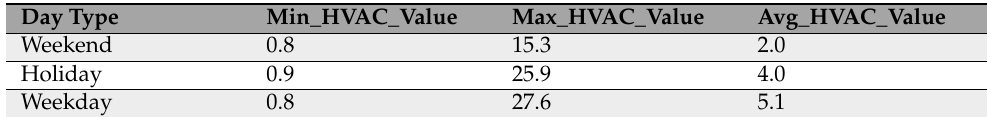
Table 4. HVAC consumption per day